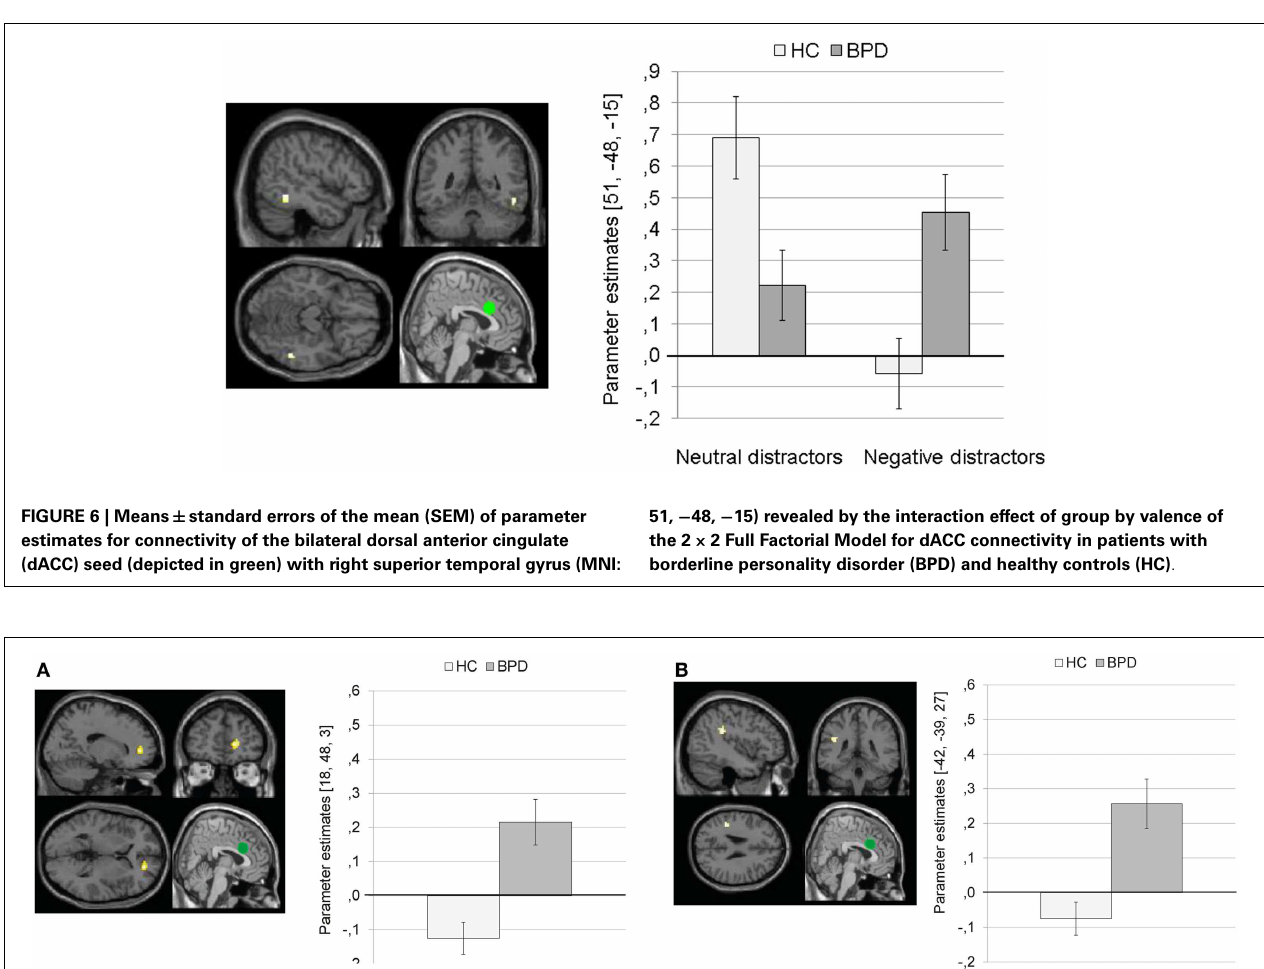
FIGURE 7 | Means ± standard errors of the mean (SEM) of parameter estimates for stronger connectivity of the bilateral dorsal anterior cingulate (dACC) seed (depicted in green) during presentation of negative distractors in patients with borderline personality disorder (BPD) than in healthy controls (HC) .